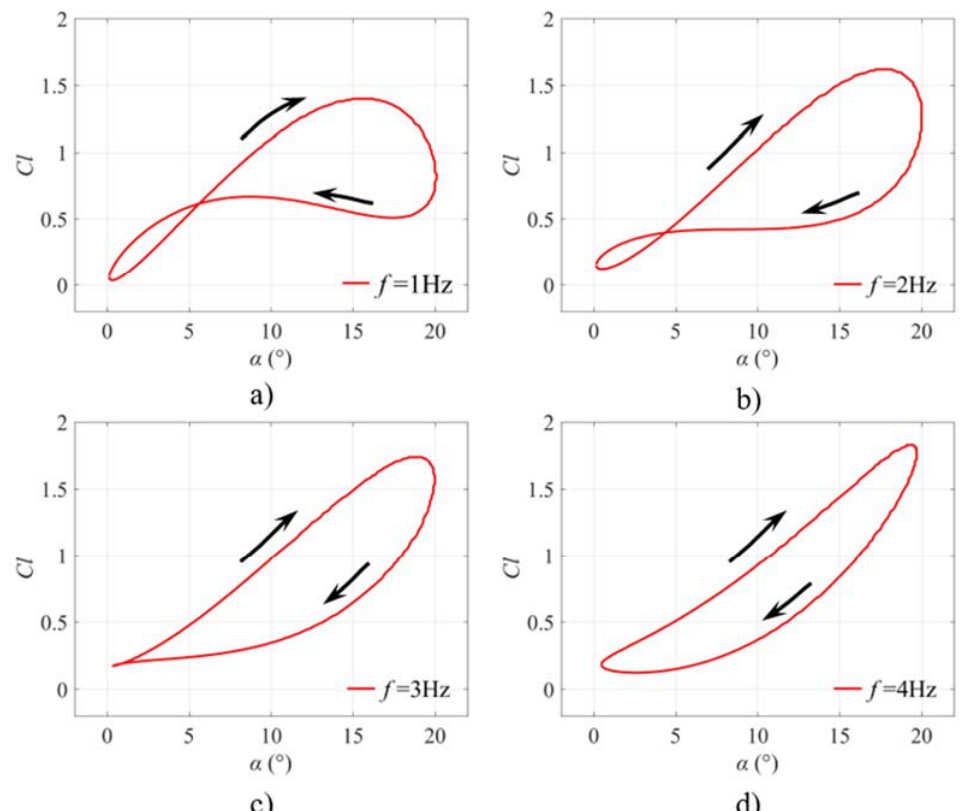
Figure 4. Phase-averaged lift coefficient ( Cl ) at frequencies of ( a ) f = 1 Hz, ( b ) f = 2 Hz, ( c ) f = 3 Hz, and ( d ) f = 4 Hz for oscillating airfoils.